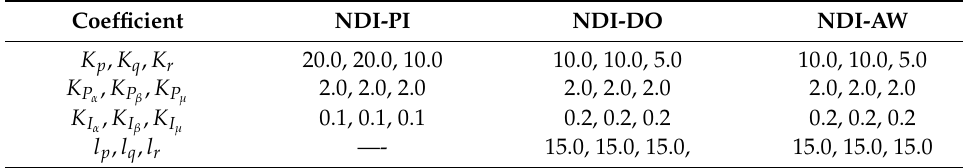
Table 3. Controller and observer gains.